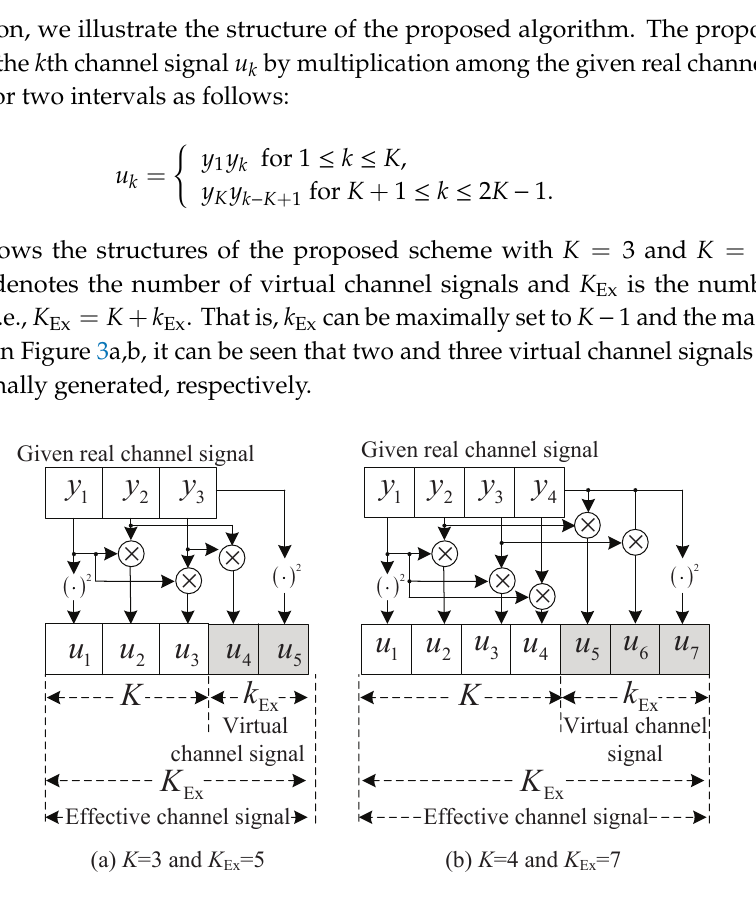
Figure 3. Structure of the proposed algorithm with K = 3 and